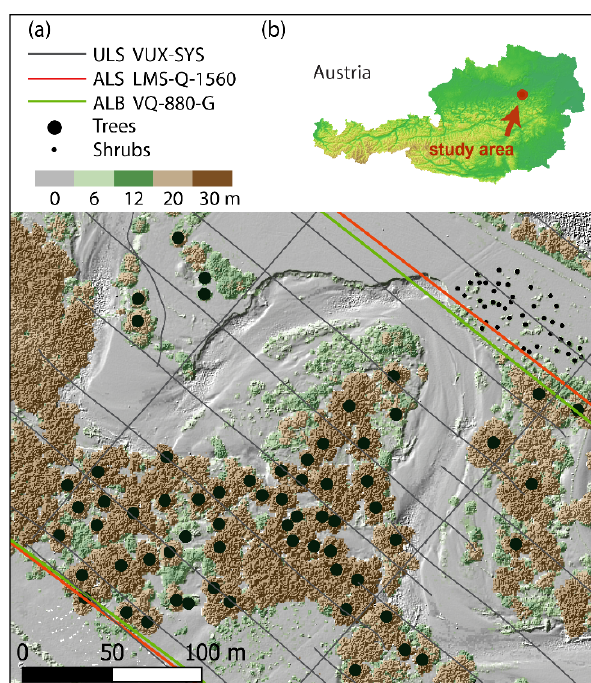
Figure 1. Overview of the study area; the ALS DSM shading is overlaid with the coloured ALS nDSM and the flight trajectories (black: ULS; red: ALS; green: ALB). The big black dots represent analysed trees while the small ones represent bushes.